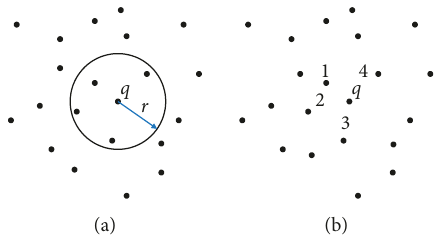
Figure 1: The nearest neighbor search of point